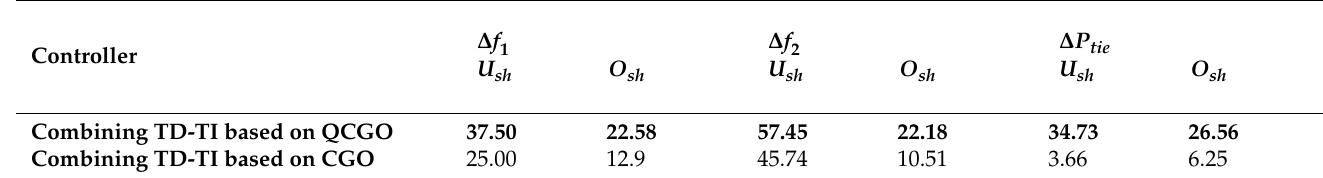
Table 21. Percentage improvement in U sh and O sh values for combining TD-TI/QCGO and combin- ing TD-TI/CGO based on combining TD-TI/SSA for scenario B.2.